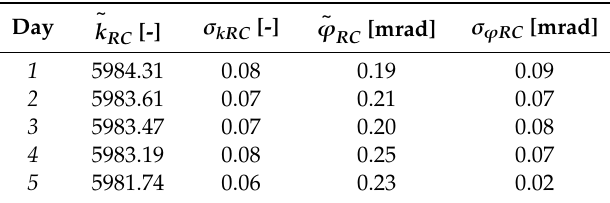
Table 2. Actual ratio and phase displacement of the R-C divider + DAQ measurement chain, together with their standard deviations when 1000 V are applied.